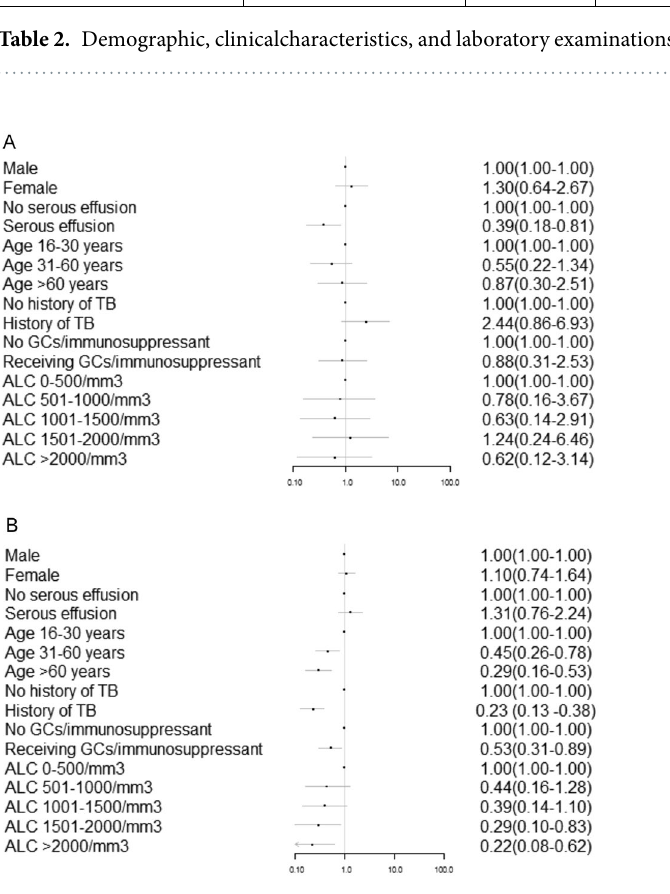
Figure 2. The factors which influence the sensitivity ( A ) and specificity ( B ) of T-SPOT.TB. GCs: glucocorticoids; ALC: absolute lymphocyte